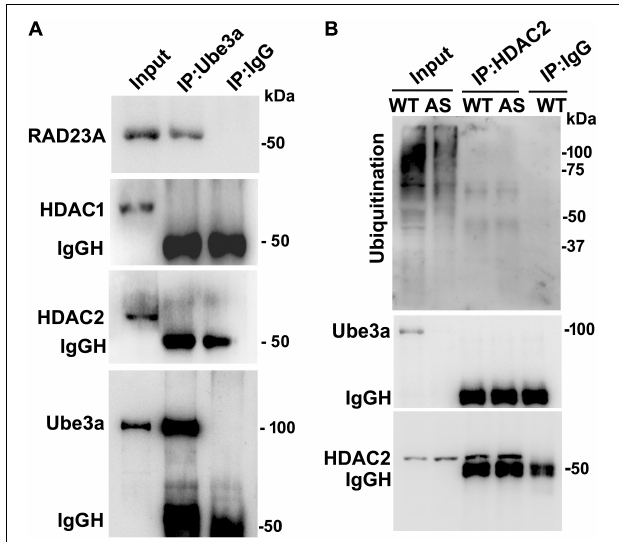
FIGURE 3 | Ube3a deficiency causes significant up-regulation in the transcript level of both HDAC1/2 and HDAC enzymatic activity. (A) HT22 cells were transiently transfected with Ube3a and control siRNA for 24 h, total RNA was extracted, cDNA was synthesized and then subjected to RT-qPCR analysis of Ube3a, HDAC1 and HDAC2 transcripts. (B) Measurement of HDAC enzymatic activity in the crude nuclear extract prepared from control and Ube3a siRNA transfected cells as described in materials and methods. Values are mean ± SD of four different experiments. (C) Cortices from wild type and AS mice (P60) were isolated, total RNA was extracted and processed for RT-qPCR. (D) HDAC enzymatic activity in cortical samples of adult (P60) wild type and AS mice. Expression levels of HDAC1 and HDAC2 mRNAs were calculated and normalized to 18S rRNA (HDAC/18 SrRNA) as an internal control. Values plotted are mean ± SD of four mice in each group. The “a” depict p < 0.001 compared to respective control siRNA (A,B) or wild type mice (C,D) group (Students t-